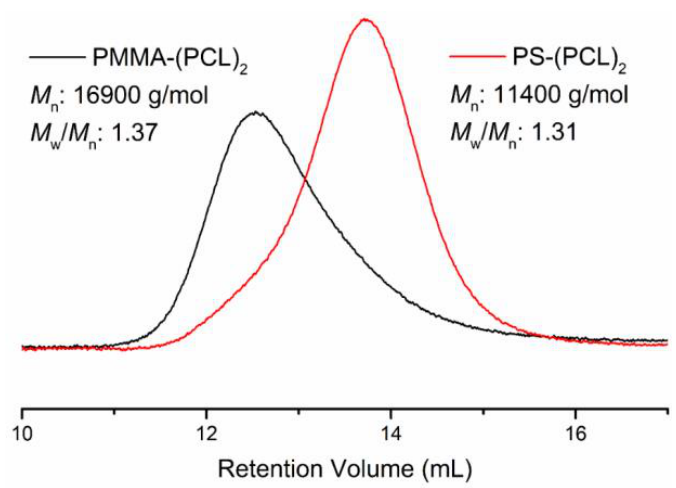
Figure 3. Gel permeation chromatography (GPC)traces of PMMA-(PCL) 2 and PS-(PCL) 2 star copolymers.